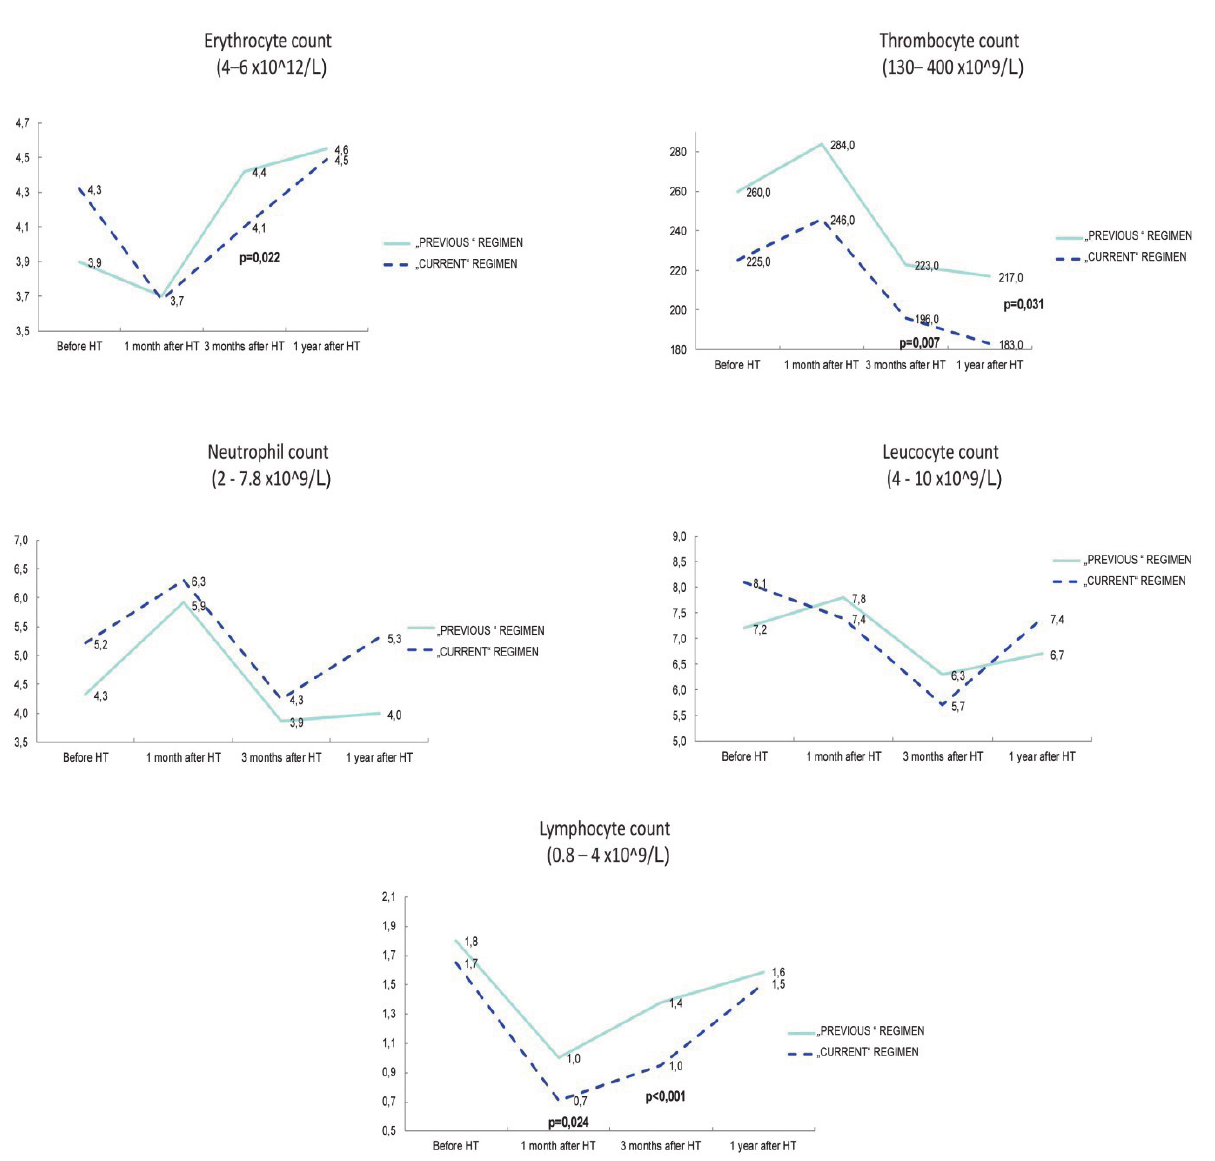
Fig. 1. Comparison of both regimens in terms of myelotoxicity (number of blood elements in reference